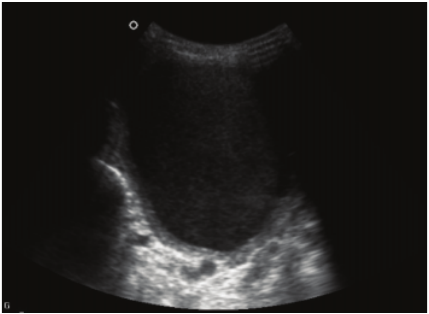
Figure 1: It shows cystic lesion of 10 × 8 cm in lateral left lobe of thyroid gland including internal echoes with some separation and posterior acoustic shadowing in ultrasound